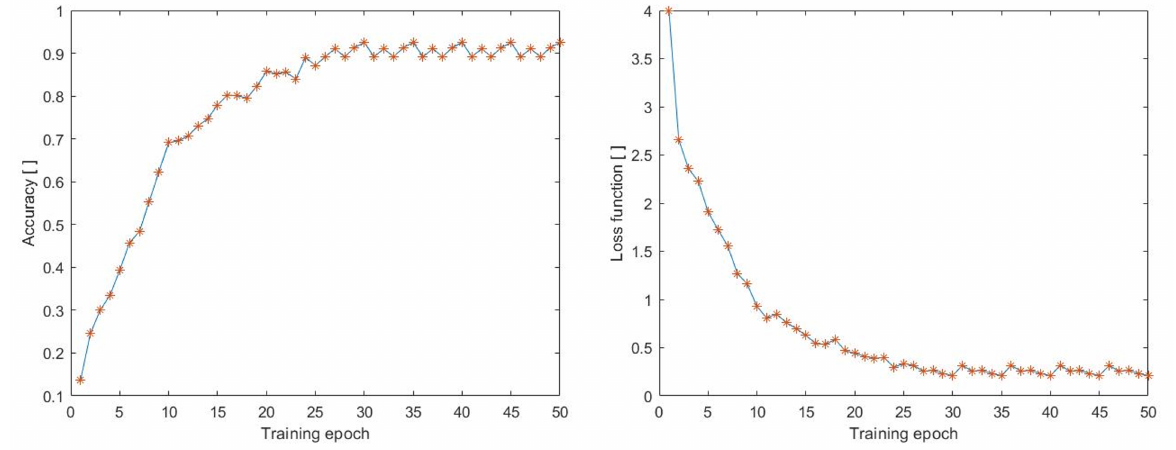
Figure 9. Accuracy during training process on the dataset (LoDVP Abnormal